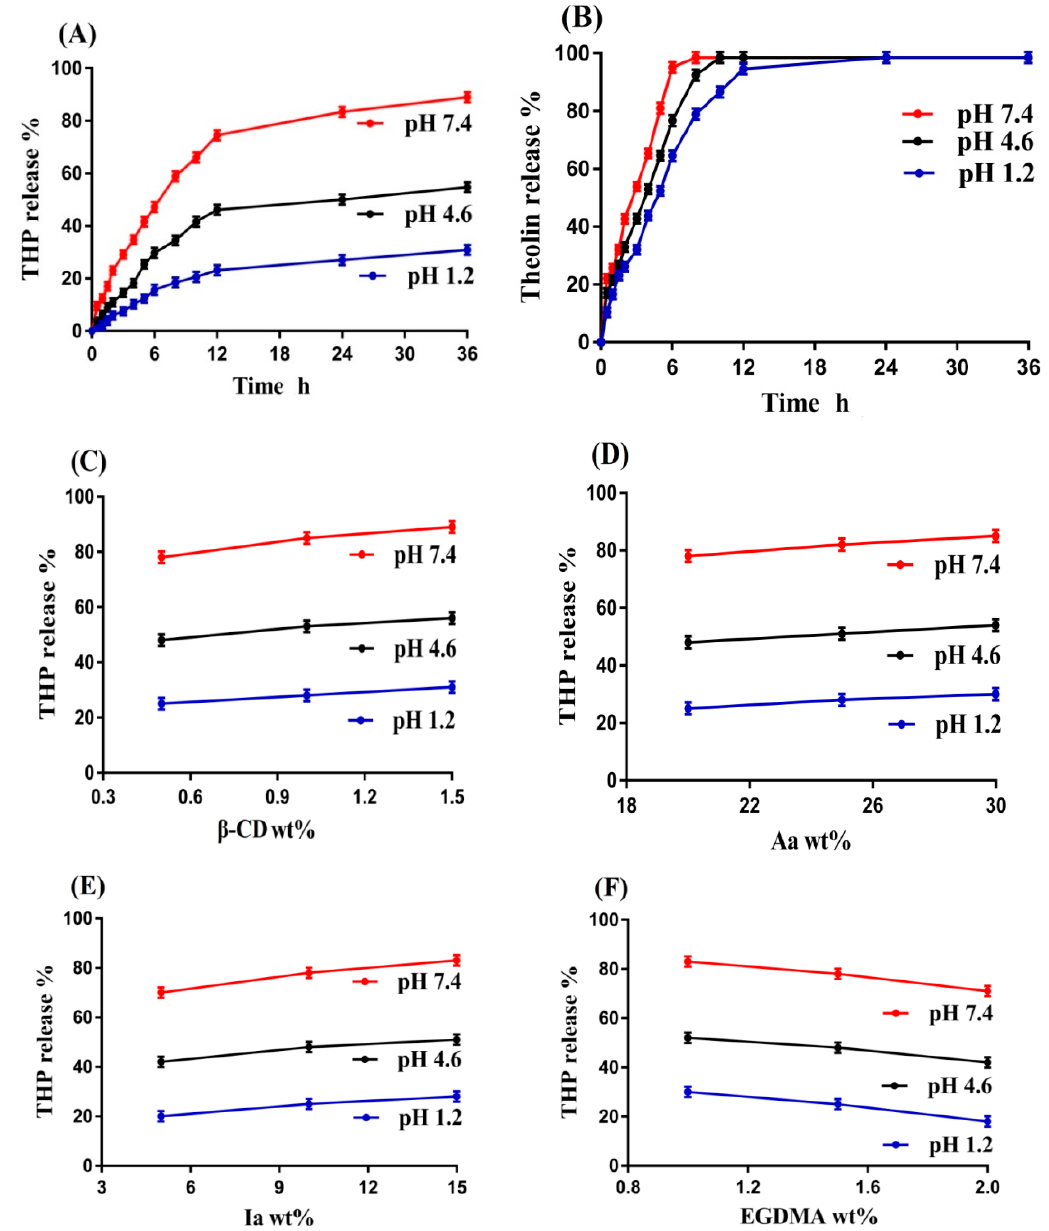
Figure 8. Effect of pH on ( A ) percent drug release from β -CD- g -P(Aa/Ia) hydrogel; ( B ) percent drug release from Theolin tablets; and effect of ( C ) β -CD, ( D ) Aa, ( E ) Ia, and ( F ) EGDMA on percent drug release from β -CD- g -P(Aa/Ia) hydrogel.